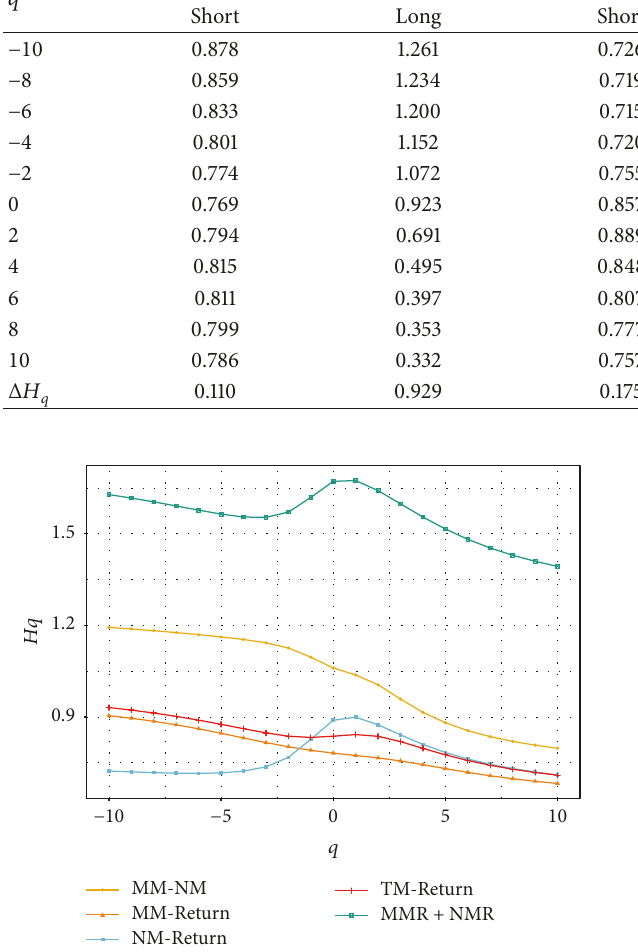
Figure 7: MF-DCCA scaling exponent for pairwise time series among two types of news and return of SSE